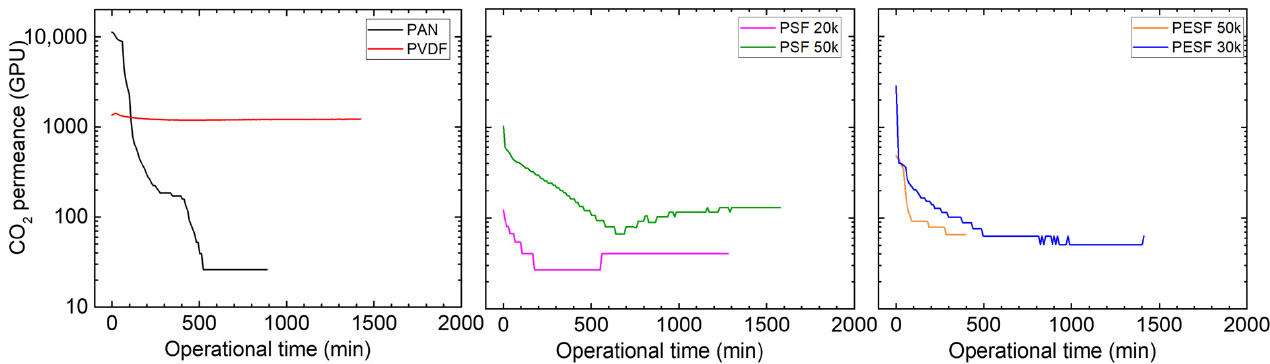
Figure 6. CO 2 permeation of the 6 porous supports selected at 100% RH, with a feed pressure of 2 bar at 35 °C.